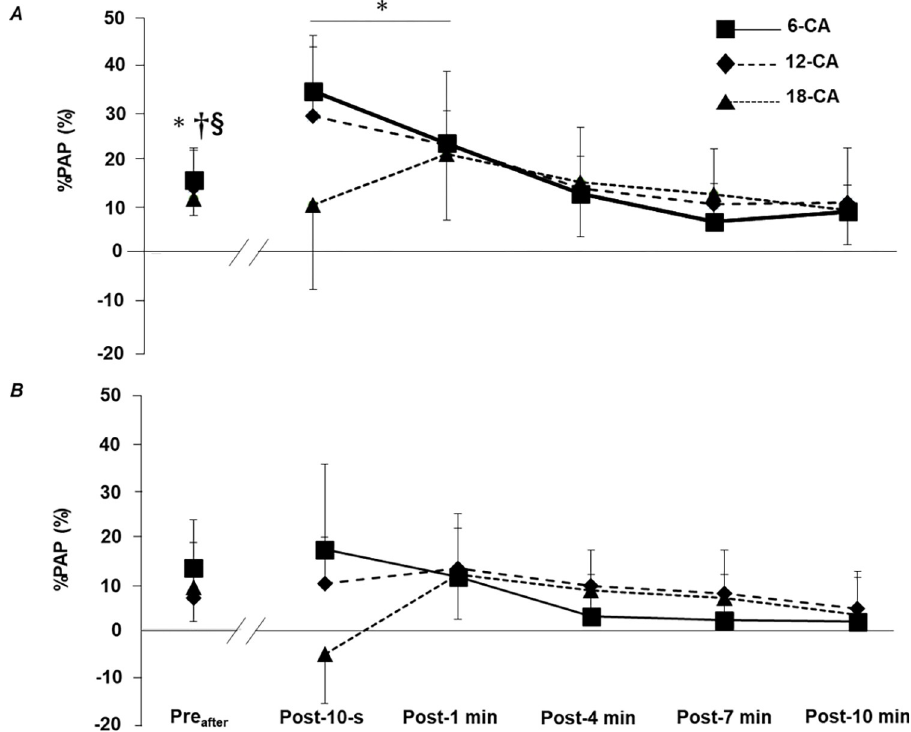
Fig 4. Time-course changes in %PAP after each CA for ( A ) stronger individuals and ( B ) weaker individuals. CA, conditioning activity. Values are presented as means ± standard deviation. The statistical difference is set at p < 0.05: difference from Pre before in 6-CA � , 12-CA † , and 18-CA §